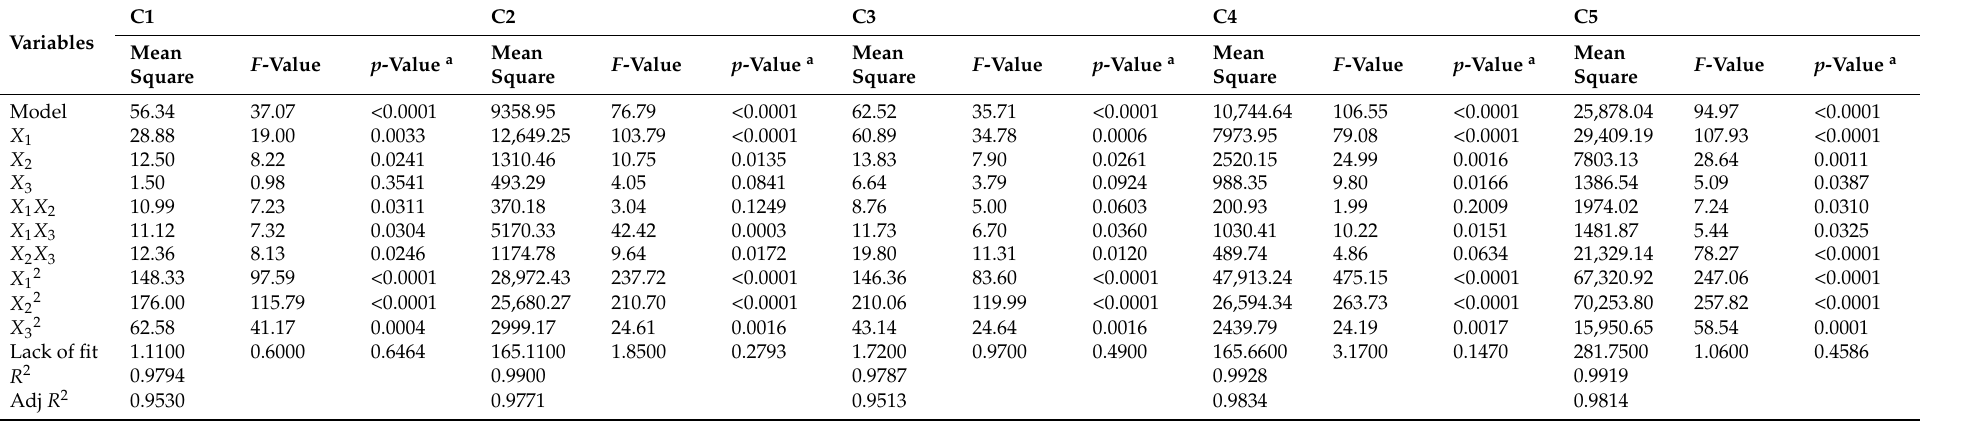
Table 3. ANOVA of the response surface quadratic model analysis for the extraction